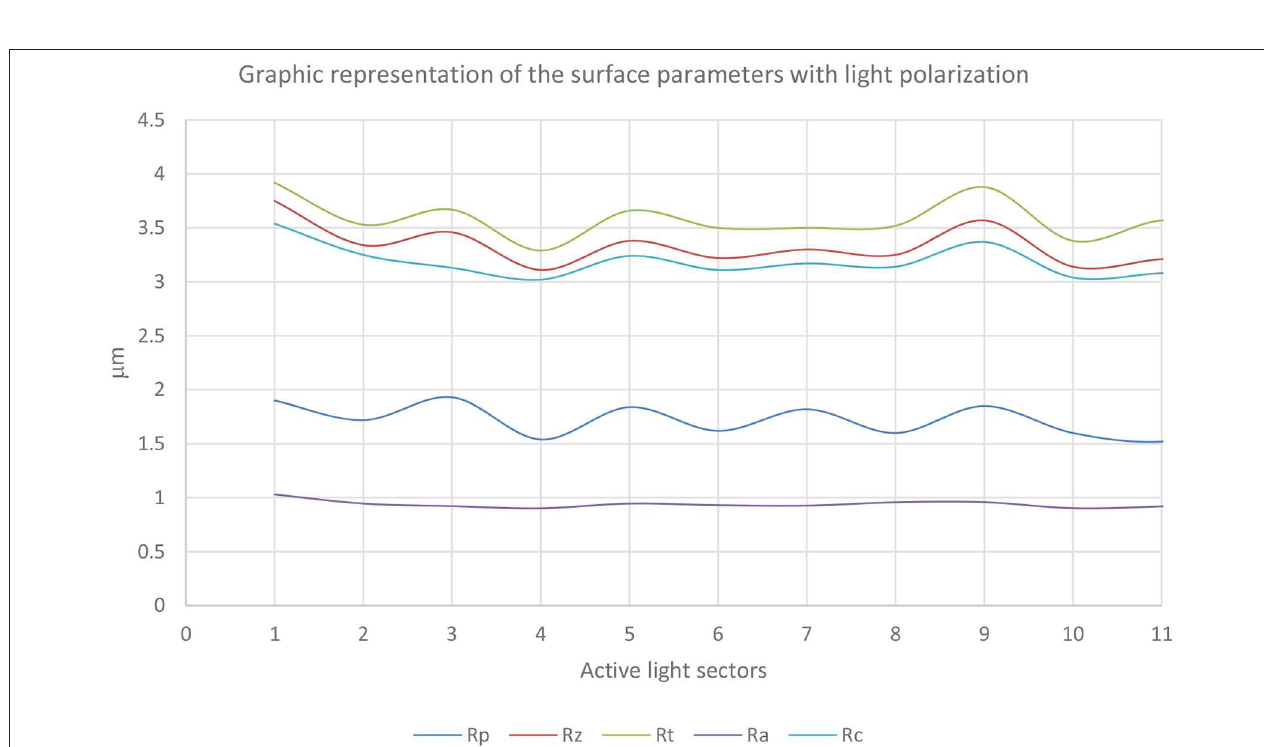
FIGURE 8 | Graphic representation of the surface parameters with light polarization depending on active light sectors.